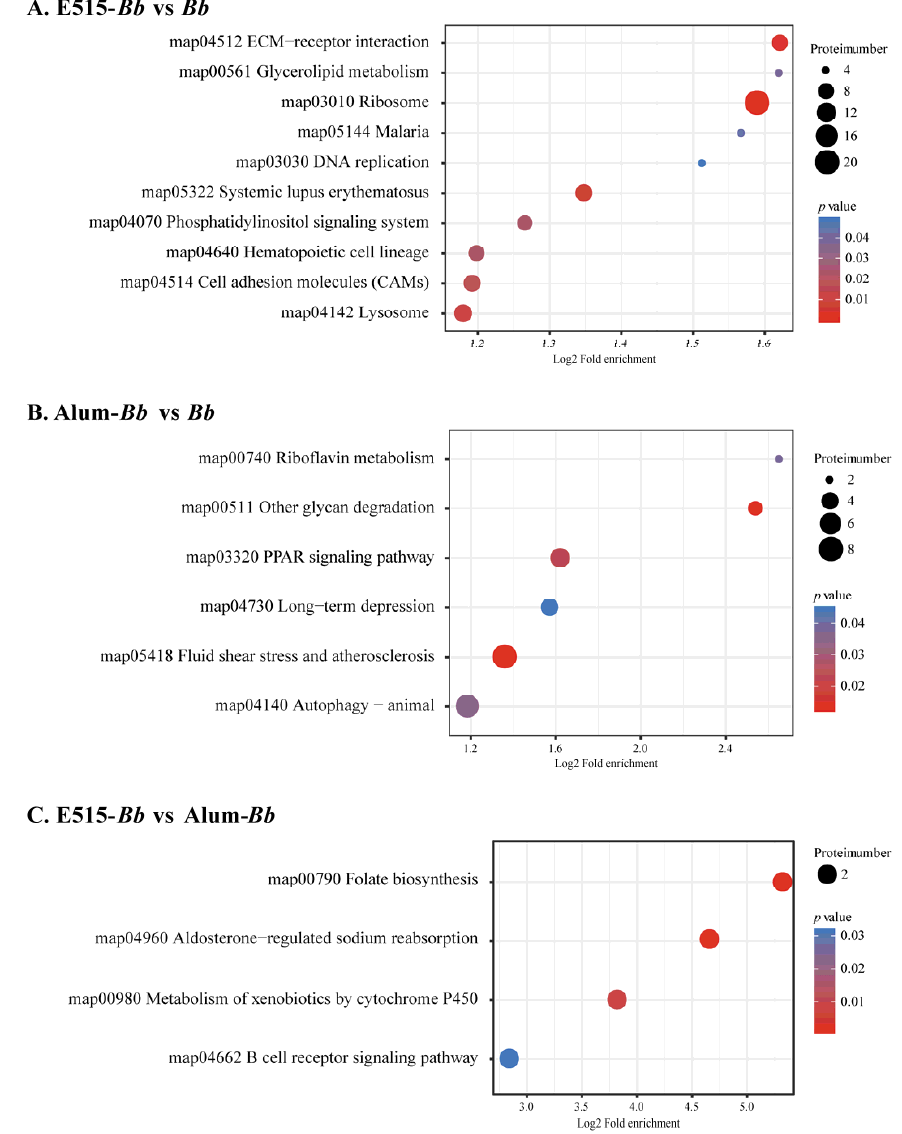
Figure 6. KEGG pathway enrichment analysis of DEPs in two comparisons. ( A ) E515- Bb vs. Bb , ( B ) Alum- Bb vs. Bb , and ( C ) E515- Bb vs. Alum- Bb . The X-axis represents the value of Log2 fold enrichment. The Y-axis represents the enrichment term of pathway. The size of the dot represents the number of DEPs. The color represents p value.